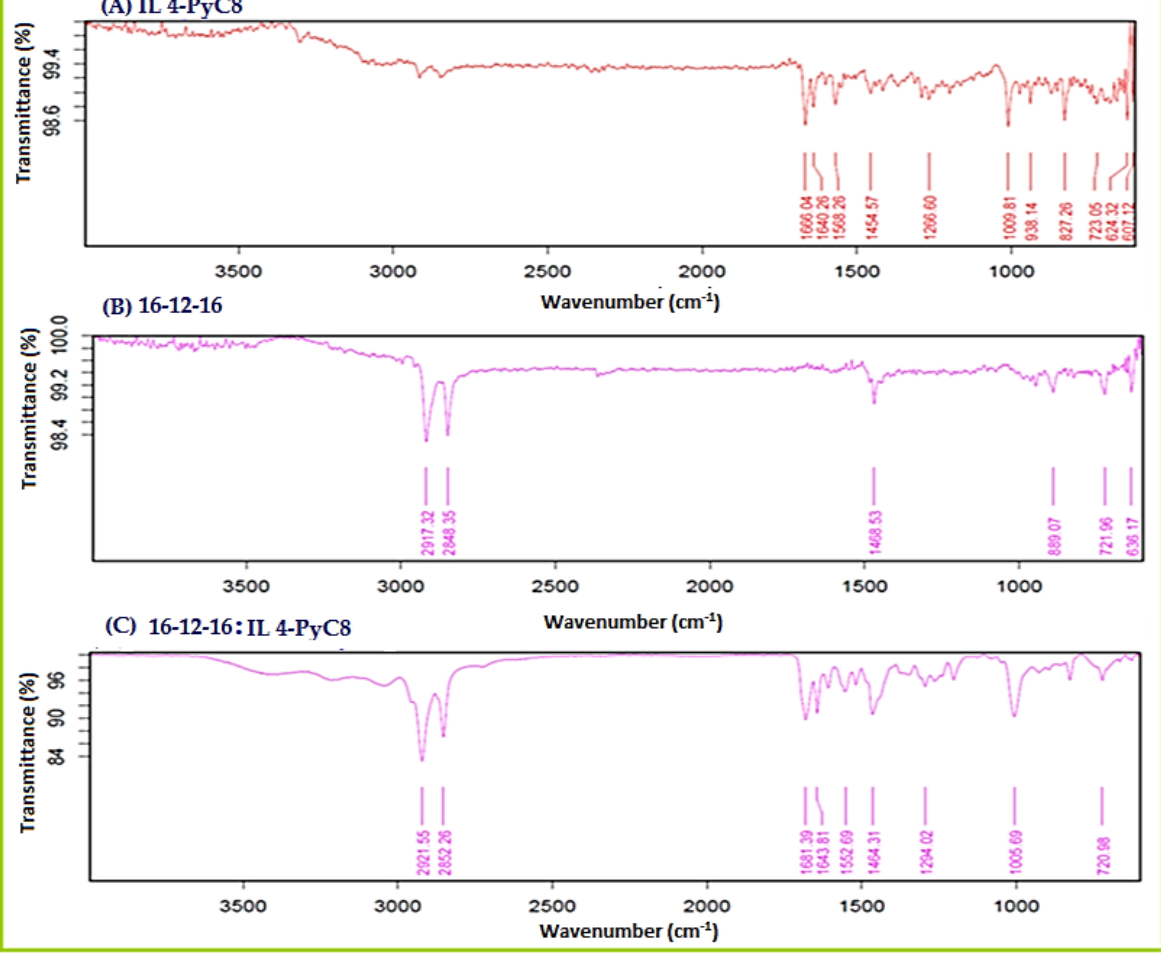
Figure 6. FTIR spectra of the ( A ) IL 4-PyC8, ( B )16-12-16 and ( C ) 16-12-16:IL